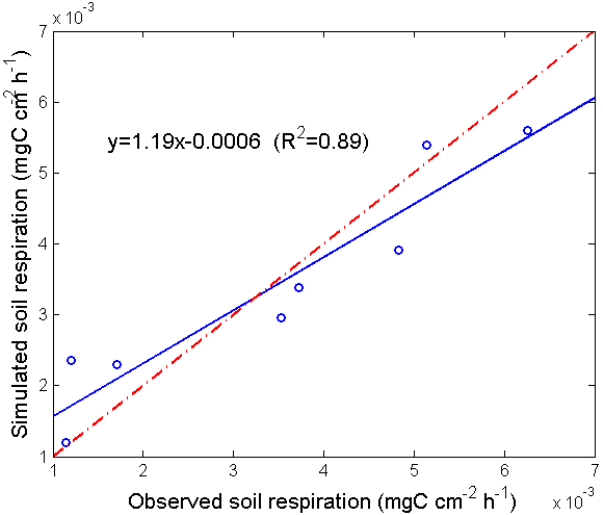
Figure 3. Simulated versus observed soil heterotrophic respiration from chamber measured monthly soil respiration during March– October 2003 in a black spruce dominated forest site in central Alaska. Model parameters were estimated using inverse modeling to match modeled soil heterotrophic respiration with